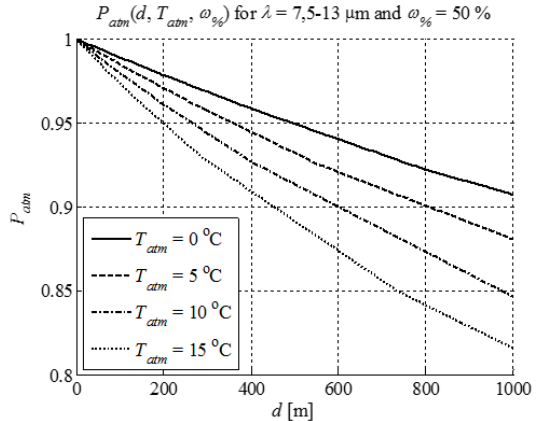
Figure 7. Characteristics of atmospheric transmission coefficient P atm = f ( d ) calculated using Passman–Larmore tables.